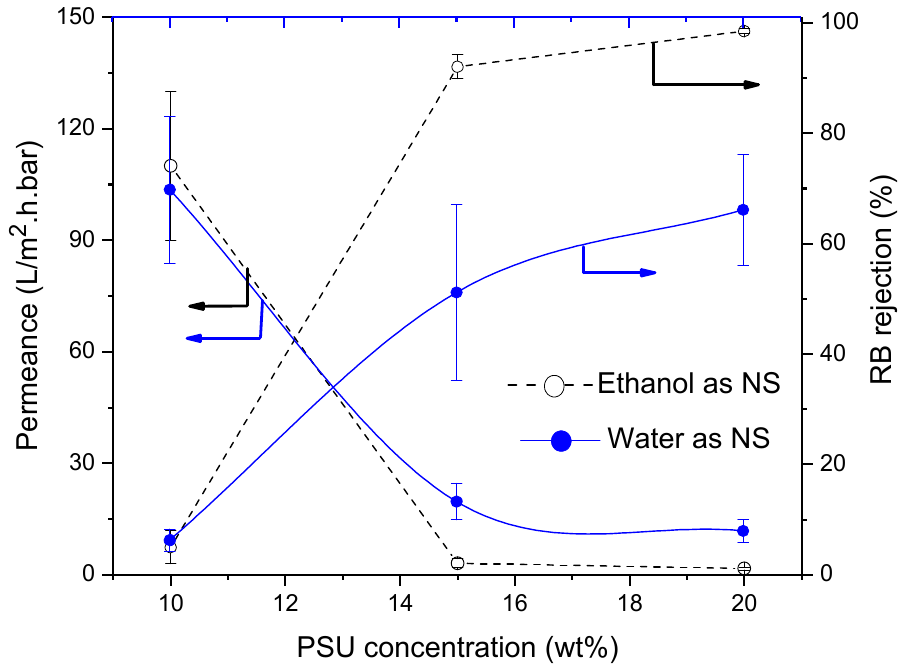
Figure 12. Influence of polysulphone (PSU) concentration on membrane performance in term of RB rejection and permeance Striped lines represent membranes prepared using ethanol as non-solvent and full lines those with water as non-solvent.